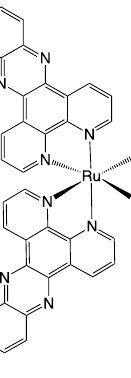
Figure 25. Structures of complexes 43 and 44a – b .